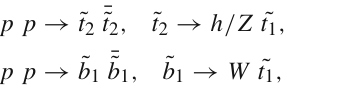
Fig. 3 Left the transverse momentum distribution for the Z boson in ˜ t 2 → Z ˜ t 1 , taking m ˜ t (cid:10) ((cid:11)φ) 2 + ((cid:11)η) 2 between the two fermions from the Z boson angular distance (cid:11) R =